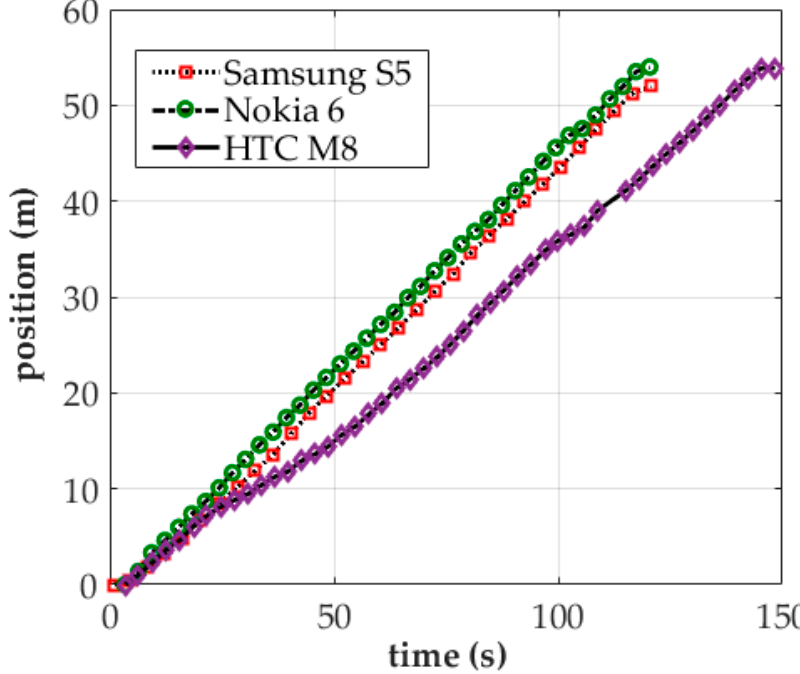
Figure 5. Time–position distribution of MS on a Samsung S5, Nokia 6, and HTC M8.